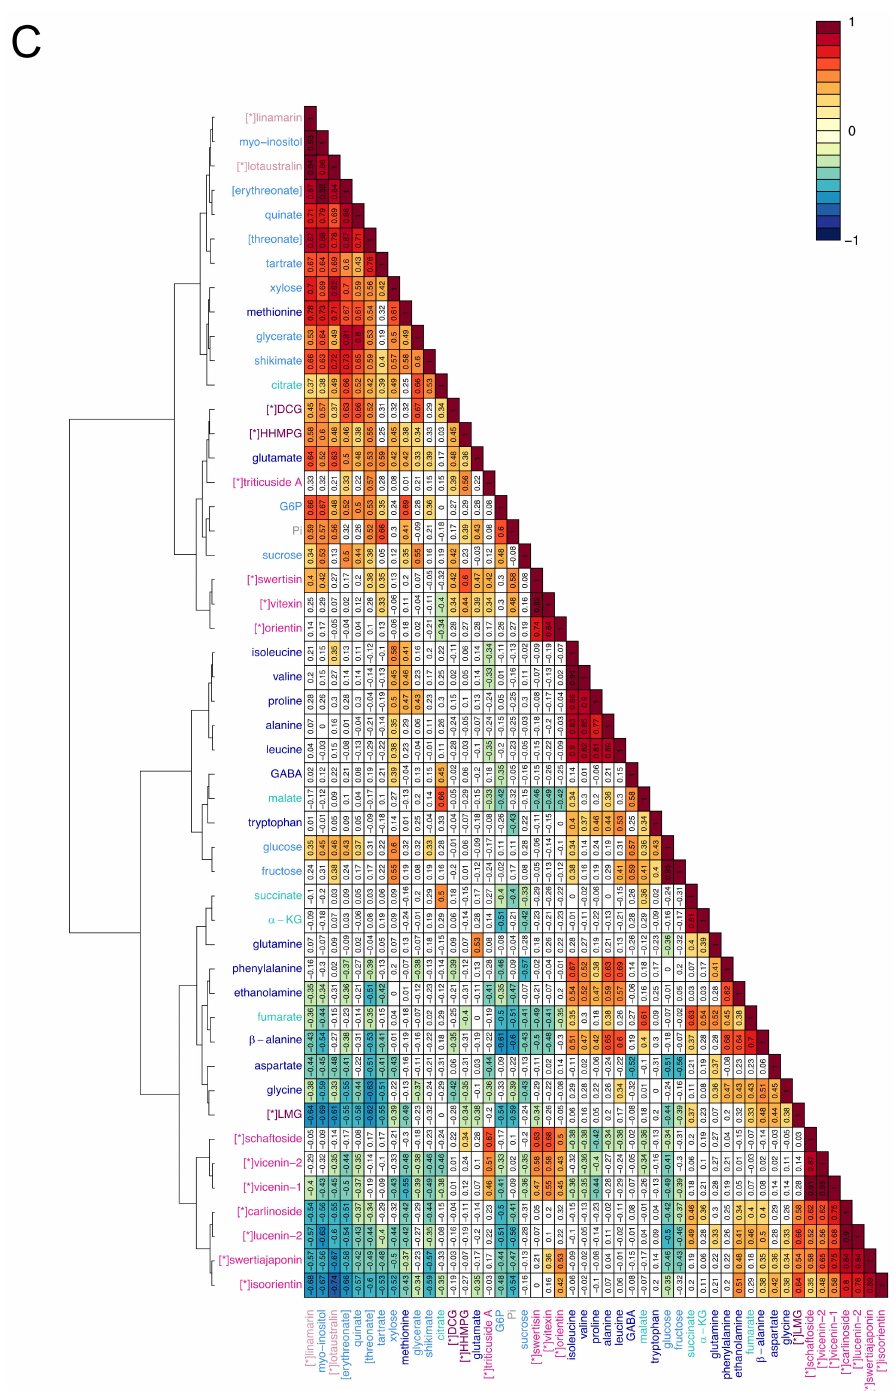
Figure 5. Heatmaps of the correlations between metabolites. Heatmaps were obtained via hierarchical cluster analysis (HCA) using the Ward clustering method. The correlation values (numbers displayed in the boxes) were calculated between couples of metabolites for the young leaf ( A ), the transition leaf ( B ), and the mature leaf ( C ) populations using Pearson correlation algorithm. Only statistically significant correlations at a correlation analysis ( α = 0.05) are coloured. For every leaf sample, n = 6. The metabolites are coloured with respect to their chemical identity: amino acids and derivatives (dark blue), carbohydrates and derivatives (light blue), tricarboxylic acids (teal), cyanogenic glycosides (pink), flavonoids (fuchsia), coniferyl alcohol derivatives (plum), and inorganic compounds (grey). [*] indicates specialized